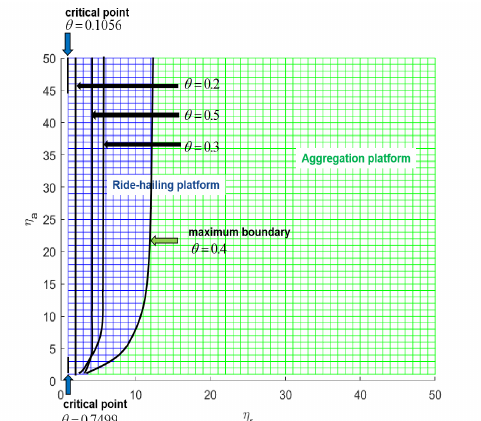
Figure 9. The boundaries and critical with the combinations of η r and η a in Model B. Figure 6 creates a three-dimensional surface plot as a sample for the case of θ = 0.35, where the red grid surface fills in Model N and the blue face grid surface fills in Model B. The function plotted the values in the ride-hailing platform’s profit ( π rn and π rb ) as heights unit